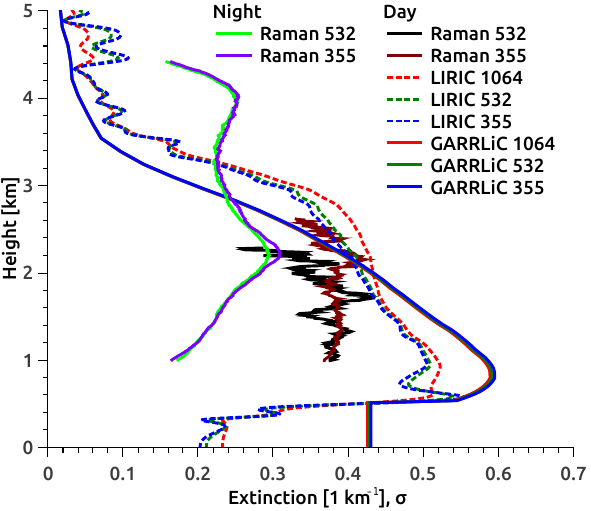
Figure 15. Raman, LIRIC, and GARRLiC extinction profiles dur- ing the day (AOD 440nm ≈ 1 . 53 ± 0 . 04 ; α ≈ 0 . 02 ± 0 . 01) and night (AOD 532nm ≈ 0 . 83 ; α ≈ 0 by Raman) on 10 April 2015.